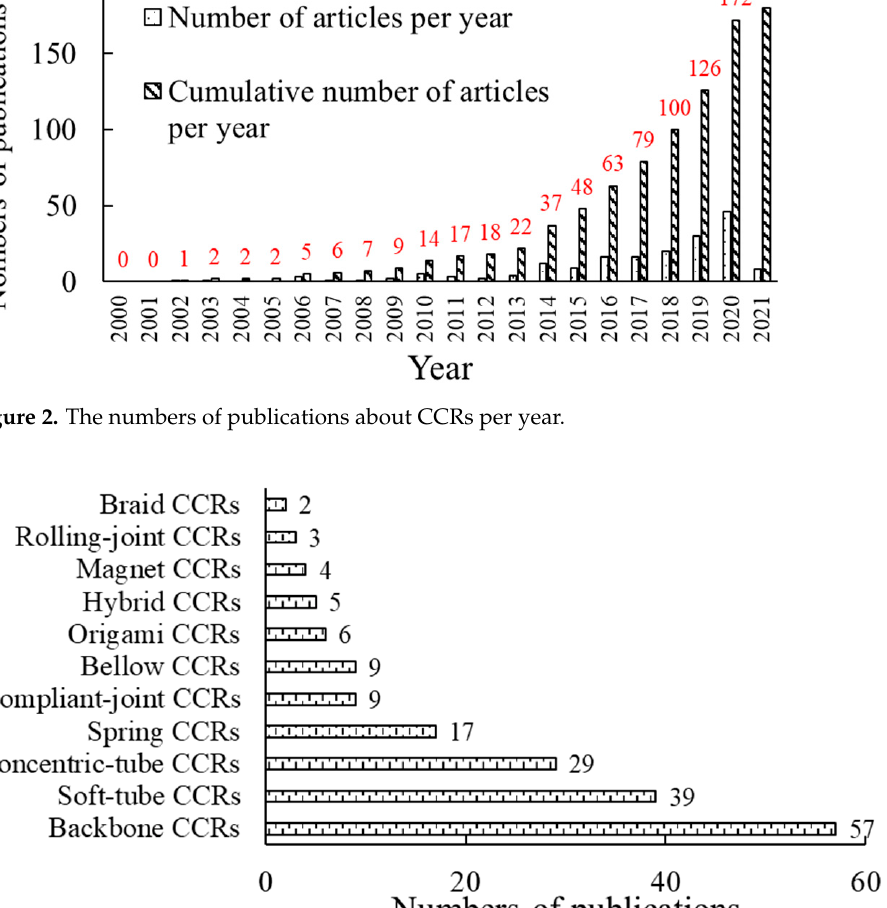
Figure 2. The numbers of publications about CCRs per year.